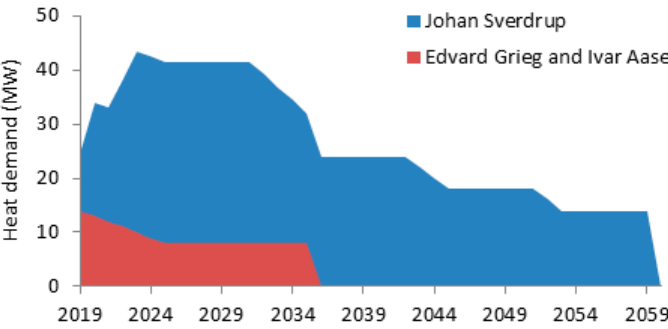
Figure 2. Heat demand profile of the Utsira High area.